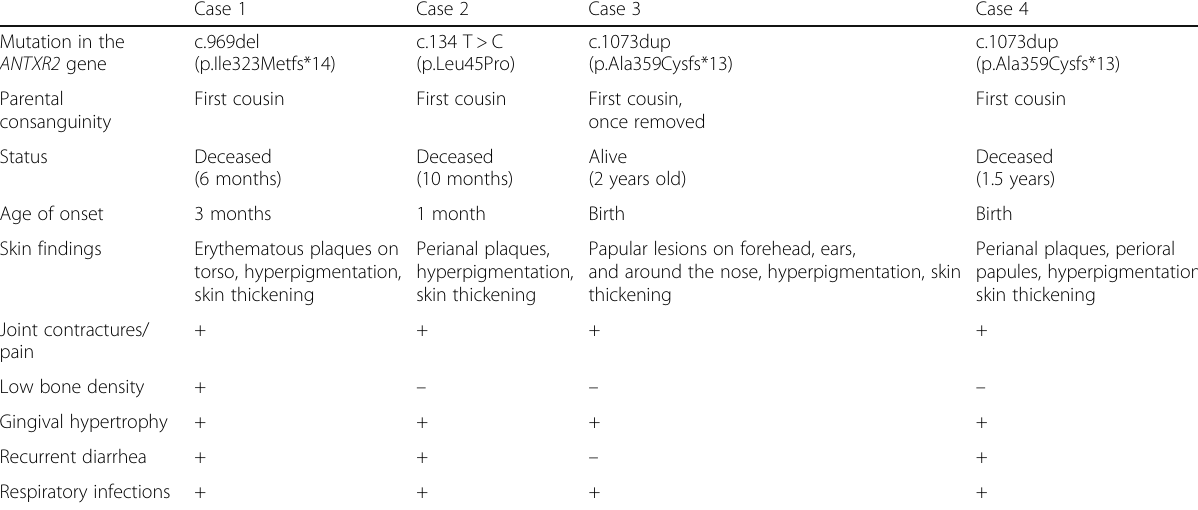
Table 1 Clinical and genetic findings in four patients with